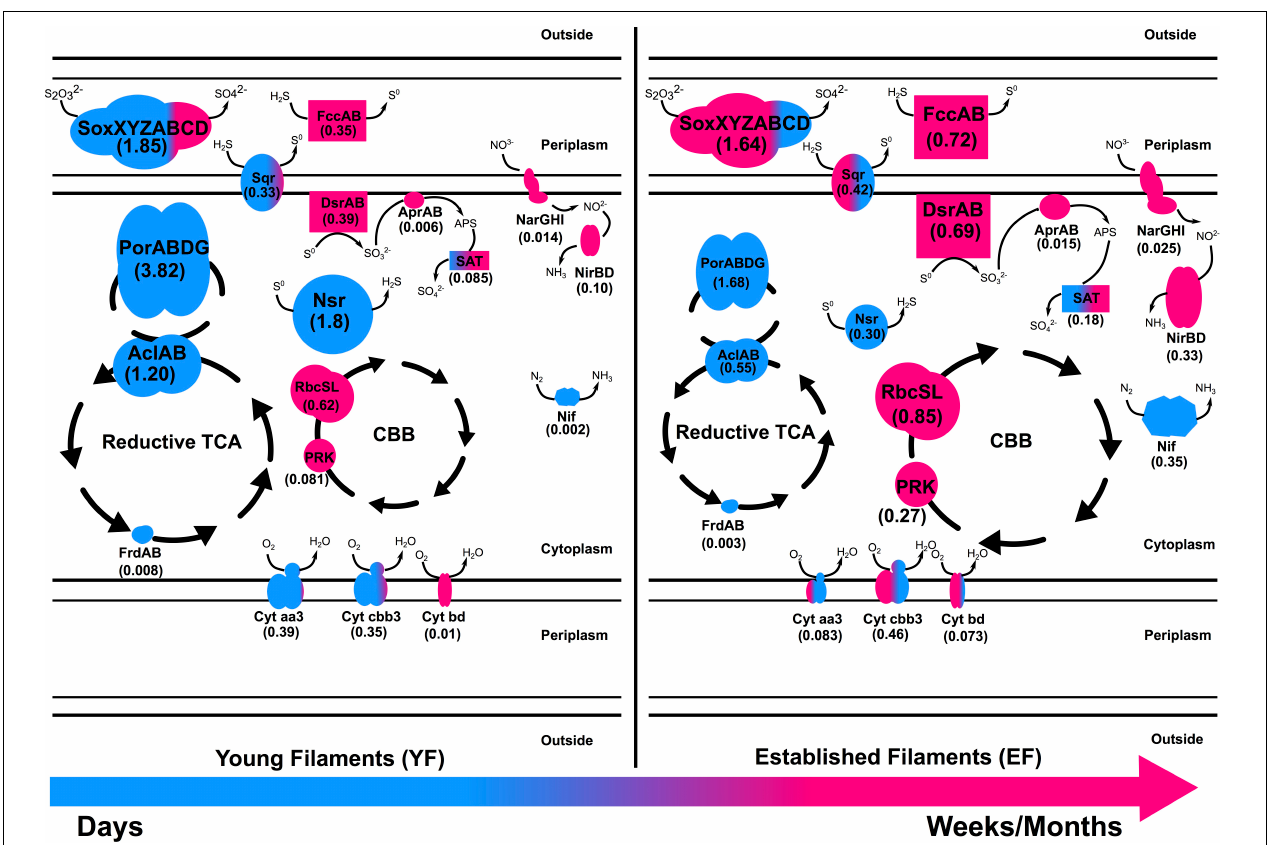
FIGURE 6 | Metaproteomic-based reconstruction of the central metabolic pathways expressed by the Tor Caldara young and established biofilm communities. The size of the enzymatic complexes is proportional to their abundance in the metaproteome. The numbers indicate the normalized protein abundance (%). The colors indicate the taxonomic affiliation of the enzymes and reflect the relative proportions of the two predominant bacterial classes. Blue: Epsilonproteobacteria ; Pink: Gammaproteobacteria